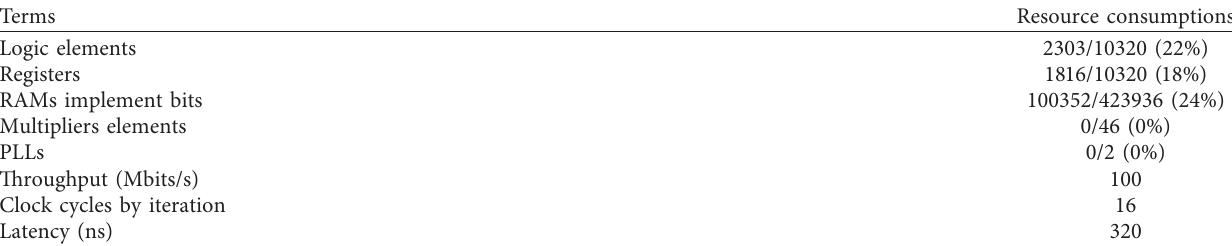
Table 2: Hardware resources required to implement the proposed multiscroll chaotic system.